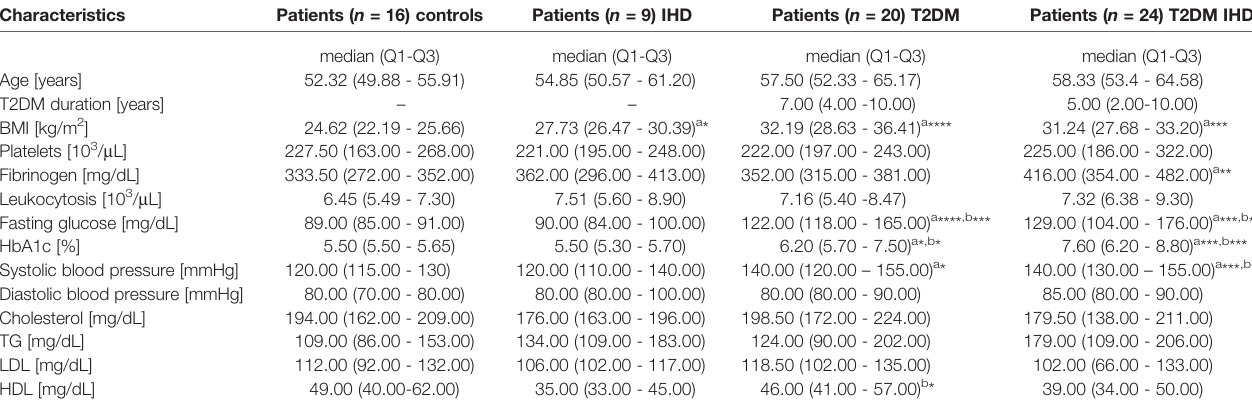
TABLE 1 | Patient baseline